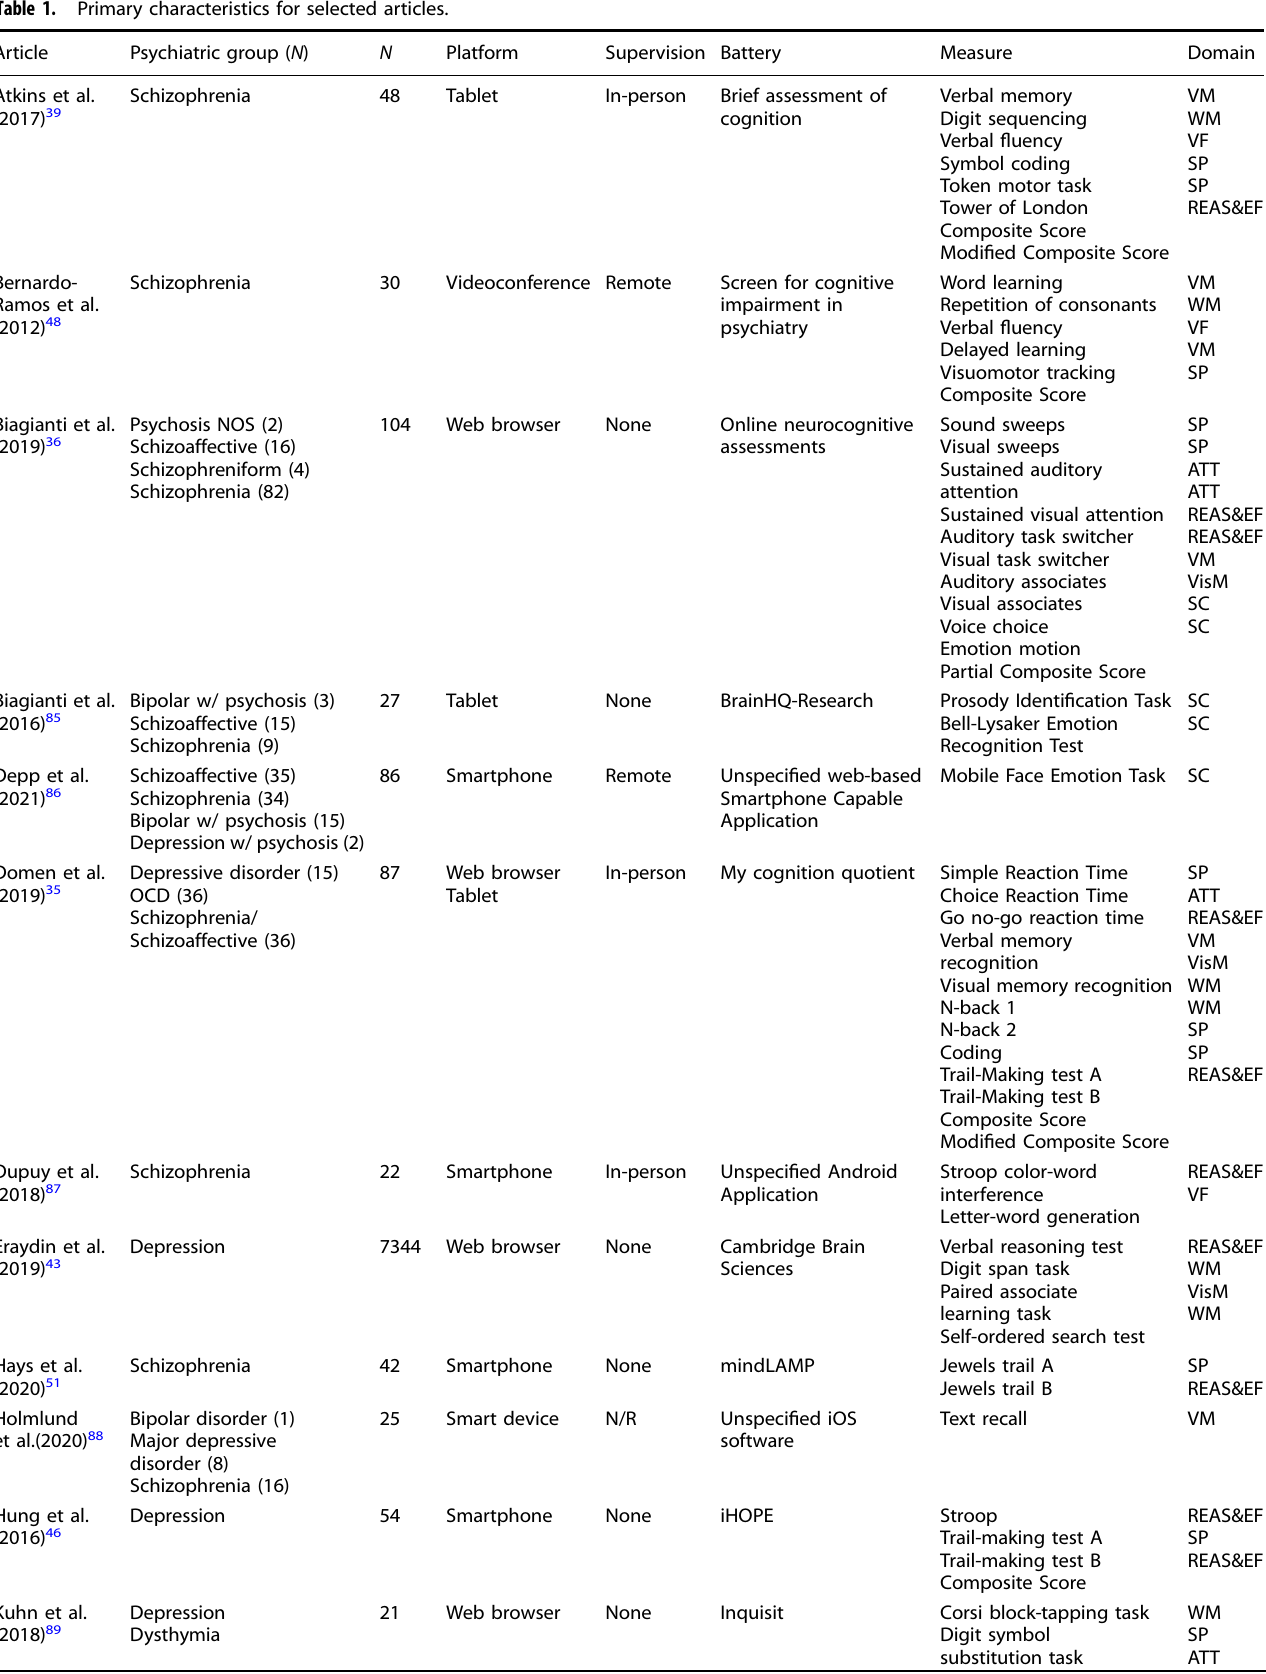
Table 1. Primary characteristics for selected